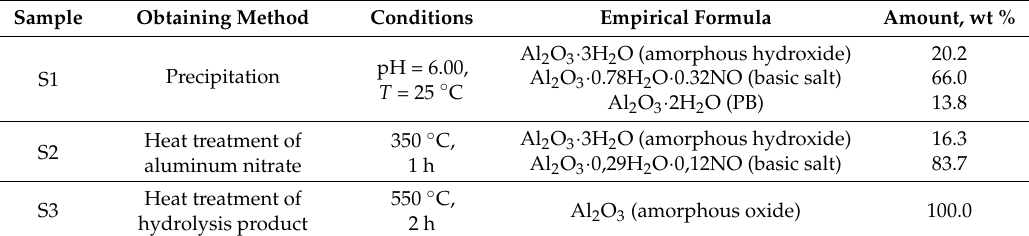
Table 3. The phase composition of amorphous S1–S3